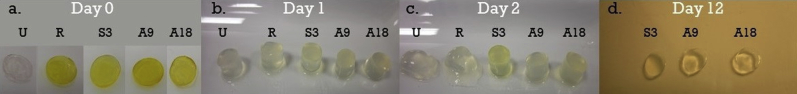
Corneal disks from left to right: untreated (U), riboflavin–dextran only (R), standard CXL 3 mW (S3), accelerated CXL 9 mW (A9), and accelerated CXL 18 mW (A18) before (a) and after 1 day (b), 2 days (c), and 12 days (d) of immersion in pepsin digest solution. All corneal buttons are swollen after 1 day in pepsin digest solution (b). After 2 days of digestion, the anterior curvature has been lost in the untreated corneas but remains intact in the crosslinked corneas (c). After 12 days, all nonirradiated buttons have been completely digested and only the anterior portion of the crosslinked corneas remain.